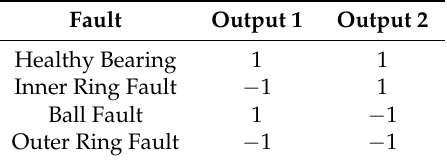
Table 3. Output layer classification.